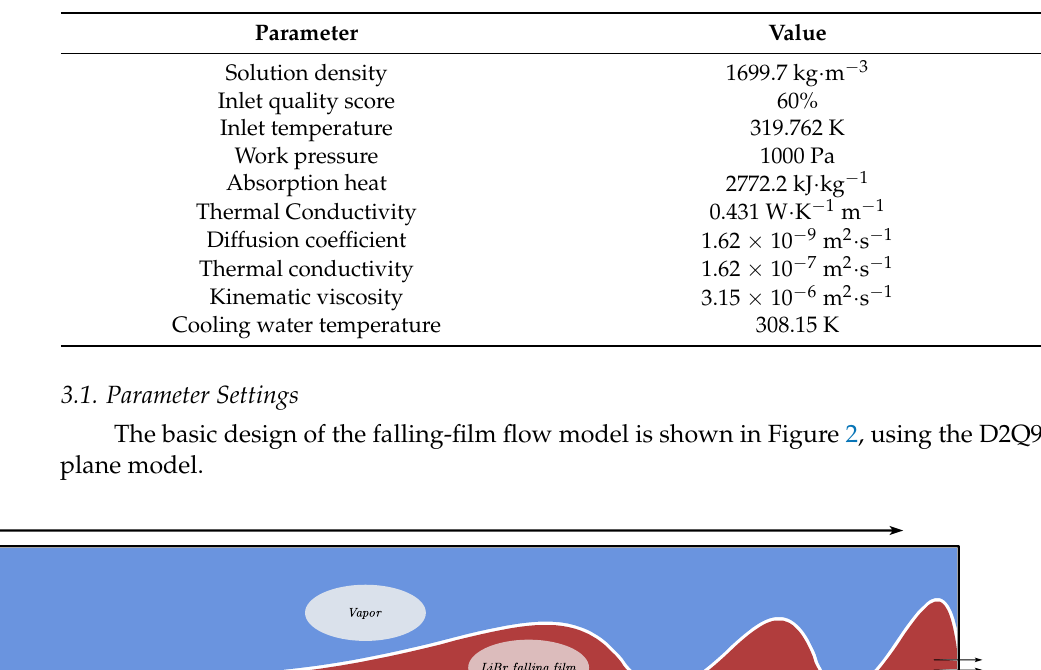
Table 1. Falling-film absorption parameter settings.